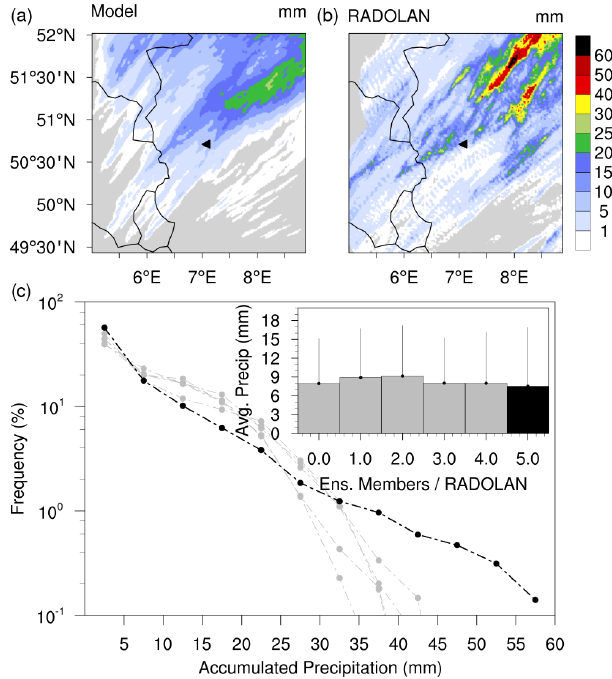
Figure 6. Spatial pattern of accumulated precipitation. (a) Ensem- ble average from the model. (b) RADOLAN estimates. The black marker shows the location of BoXPol. (c) Frequency distribution of the simulated and observed accumulated precipitation. The inset shows the domain-averaged accumulated precipitation for each en- semble member (light gray color bar) and observation (black color bar) with 1 standard deviation (solid line above the bars).